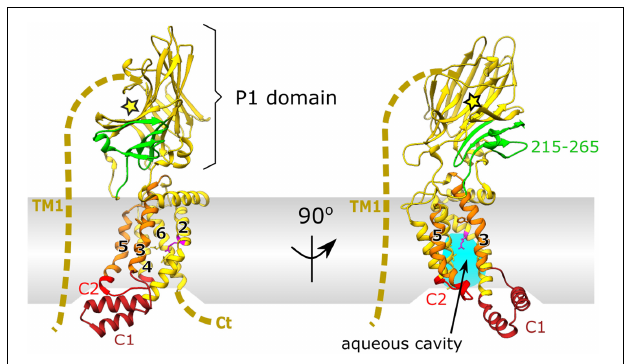
FIGURE 2 | X-ray crystal structure of YidC from E. coli PDB:6AL2 (Tanaka et al., 2018). Cytoplasmic loop C1 (dark red) and flexible cytoplasmic C2 loop (red). The conserved 5 helical core of TM2-5 is shown in yellow with hydrophobic, greasy slide helices TM3 and 5 highlighted in orange. Periplasmic domain (P1) is shown in yellow, with the SecF interaction site in green (residues 215–265) and the substrate binding cleft depicted by a yellow star. The unknown structure of non-conserved TM1 and the C-terminus is depicted by a dashed yellow line. Conserved arginine residue (R366) on TM2 of the hydrophilic groove, important for insertion, within the aqueous cavity is shown in